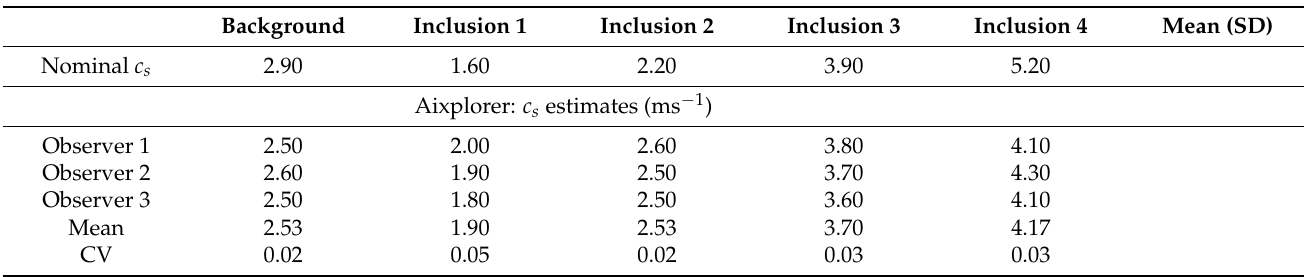
Table 1. Individual and mean shear-wave speed ( c s ) estimates from the Aixplorer and the S2000 and the coefficient of variation (CV) of c s estimates across three observers. Individual estimates were the mean of three repeat measurements. The means and standard deviations of the symmetric percentage differences are given for each observer in the last column. The manufacturer’s nominal c s values for background and inclusions are